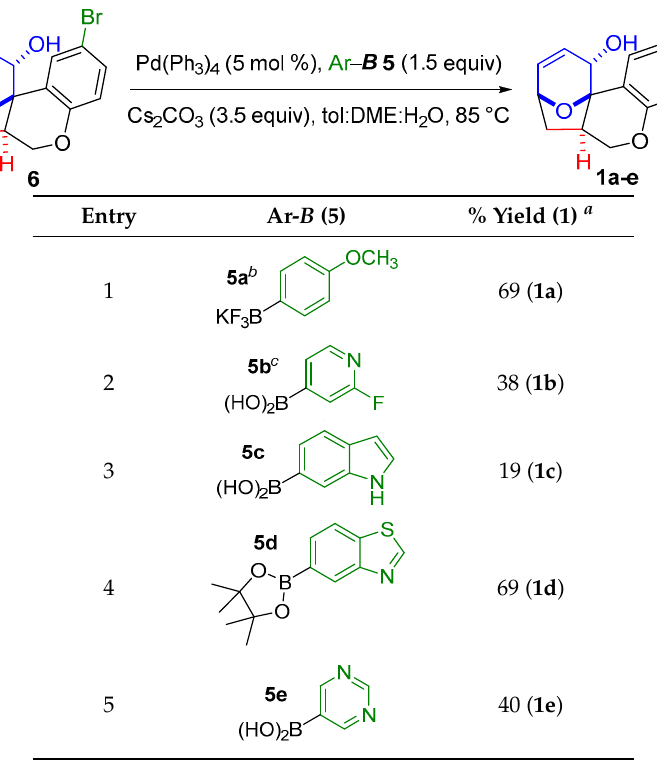
Table 1. Suzuki-Miyaura cross-coupling with aryl bromide 6.